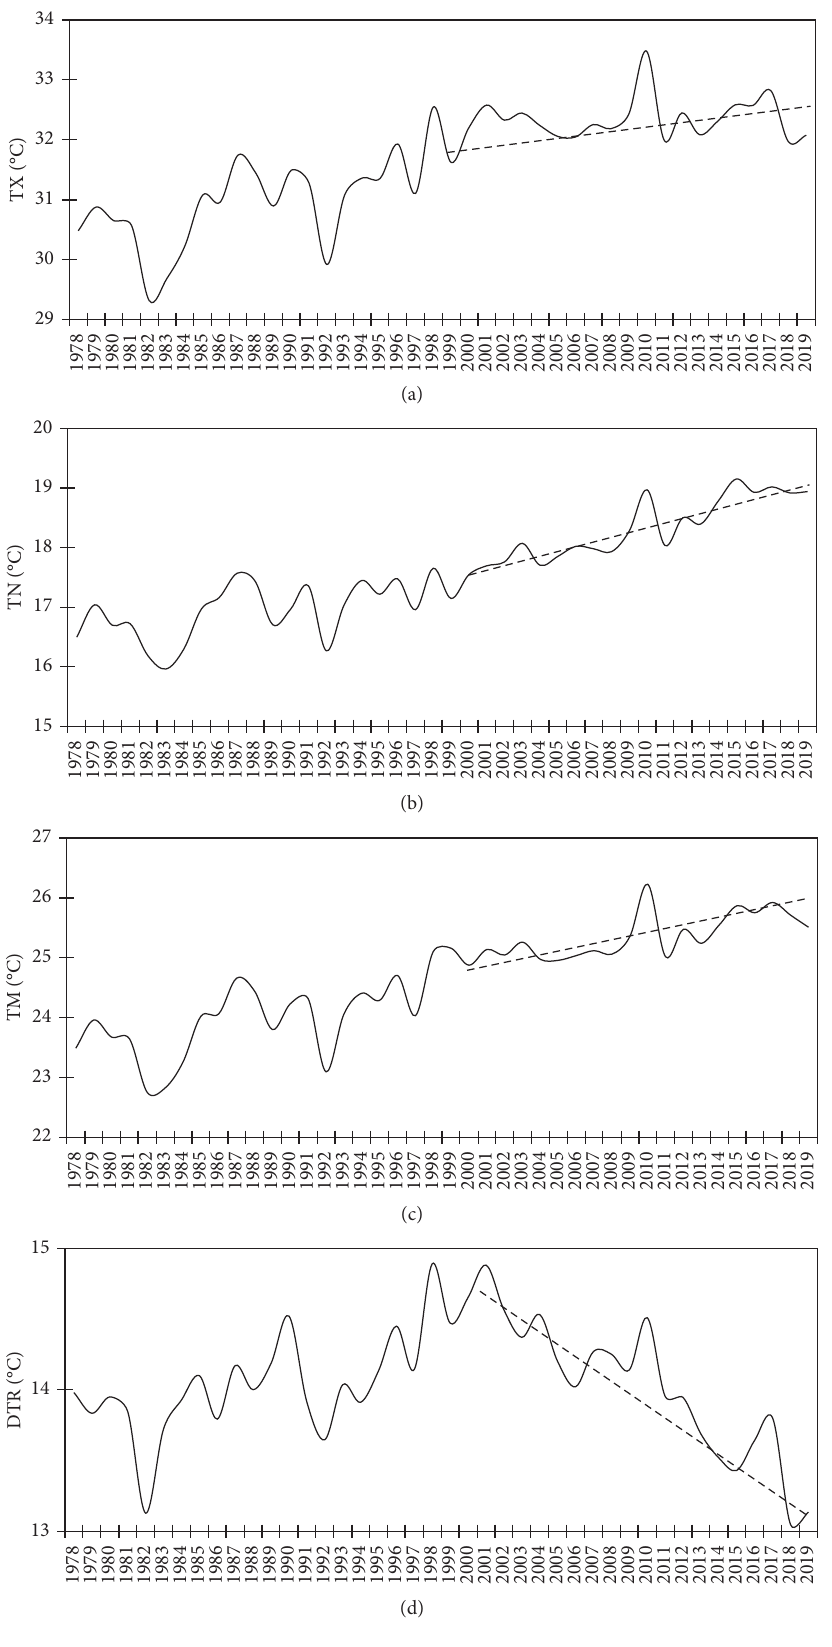
Figure 2: Country-averaged annual mean temperature for (a) maximum (TX), (b) minimum (TN), (c) mean (TM), and (d) diurnal temperature range (DTR) in Saudi Arabia for the period 1978–2019. The dashed lines are linear trends for the second period (2000–2019). The scales for vertical axis are nor the same for all